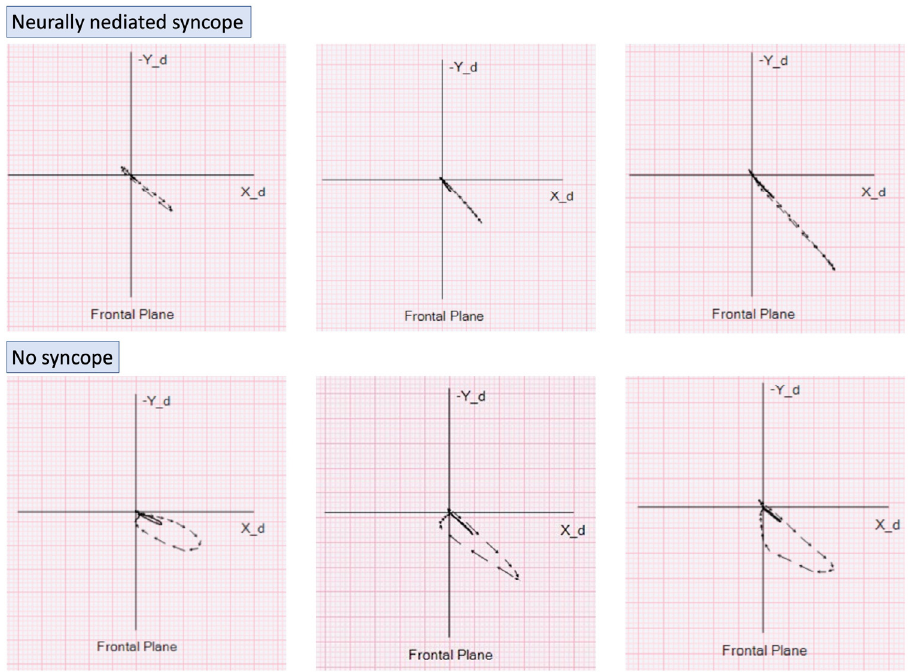
Figure 6. Examples of flat vectorcardiographic loops in the frontal plane in three patients with neurally mediated syncope—top panel. Vectorcardiographic loops in the frontal plane in three subjects with no history of syncope—bottom panel.